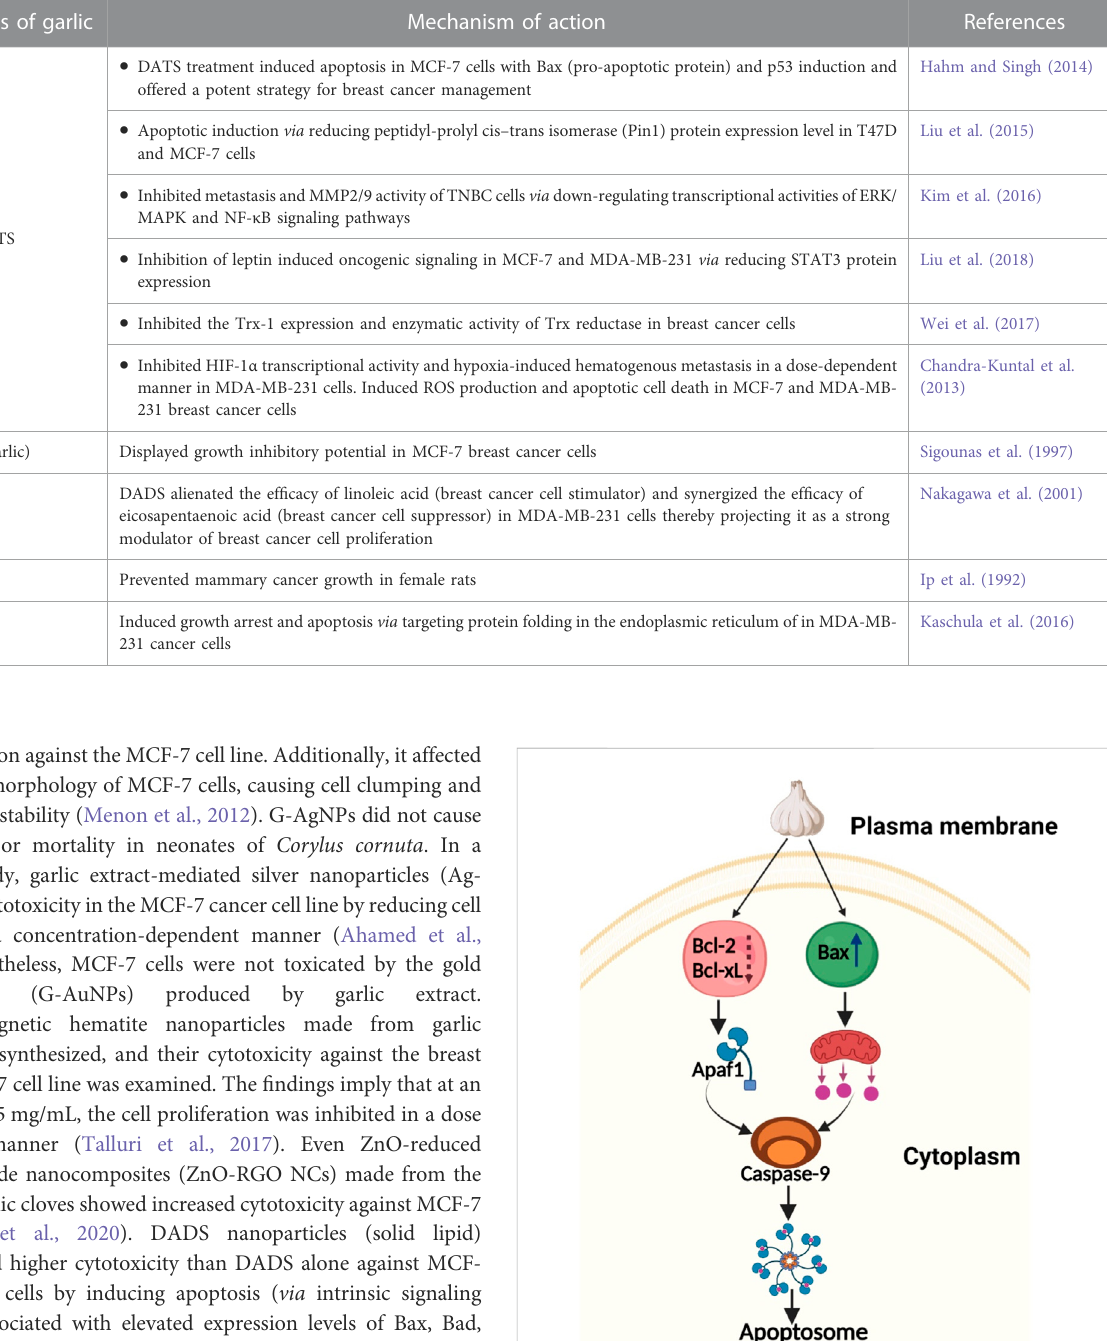
TABLE 2 Anticancer effects of garlic constituents on breast cancer. Components of garlic Mechanism of action